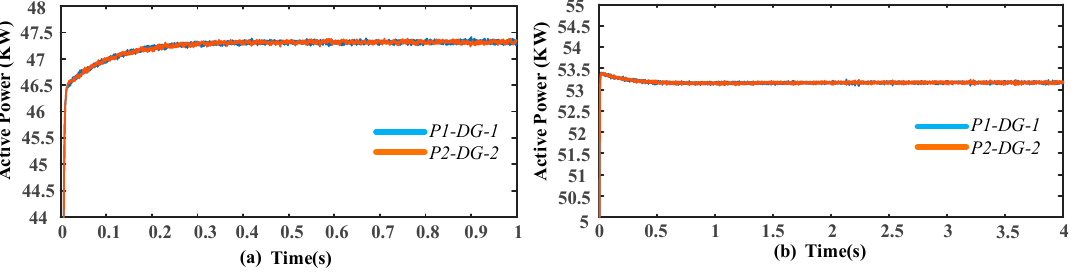
Figure 7. ( a ) Active power for the conventional control strategy; ( b ) active power for proposed control strategy.